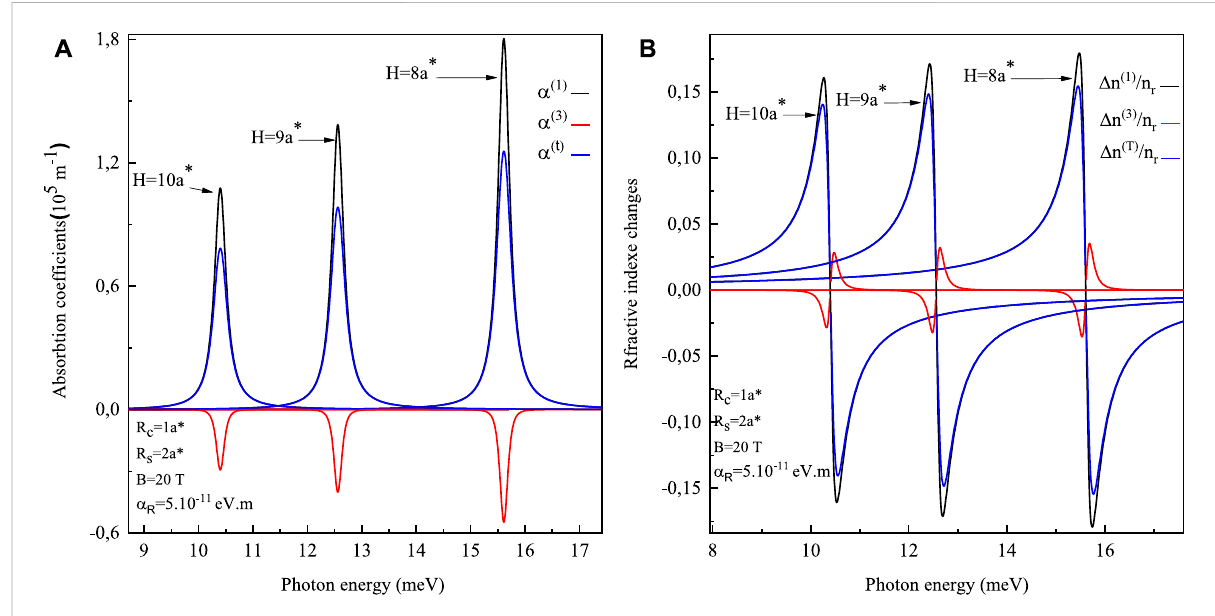
FIGURE 10 The linear, the third order nonlinear and the total absorption coef fi cients (A) and refractive index changes (B) as functions of incident photon energy for different heights H = 8, 9 and 10 a * of the CCSQD with R c = 1 a *, R s = 2 a *. The SOI strength is α R = 5 × 10 − 11 eV m , and B = 20T